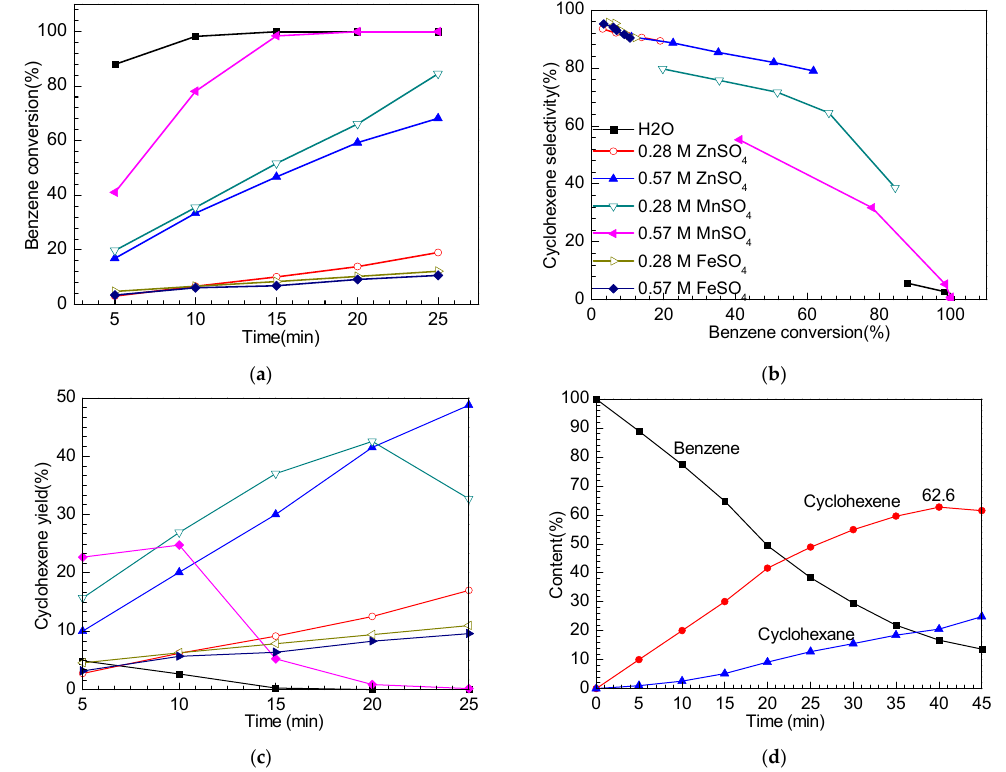
Figure 9. Catalytic activity towards benzene conversion and cyclohexene selectivity over the Ru ‐ Zn catalyst with different reaction modifiers (m cat = 1.8 g, V H2O = 280 mL, V benzene = 140 mL, T = 423 K, p H 2 = 5.0 MPa) ( a ): benzene conversion; ( b ): cyclohexene selectivity; ( c ) cyclohexene yield; and ( d ) kinetic curve over Ru ‐ Zn with addition of 0.57 mol L − 1 of ZnSO 4 .